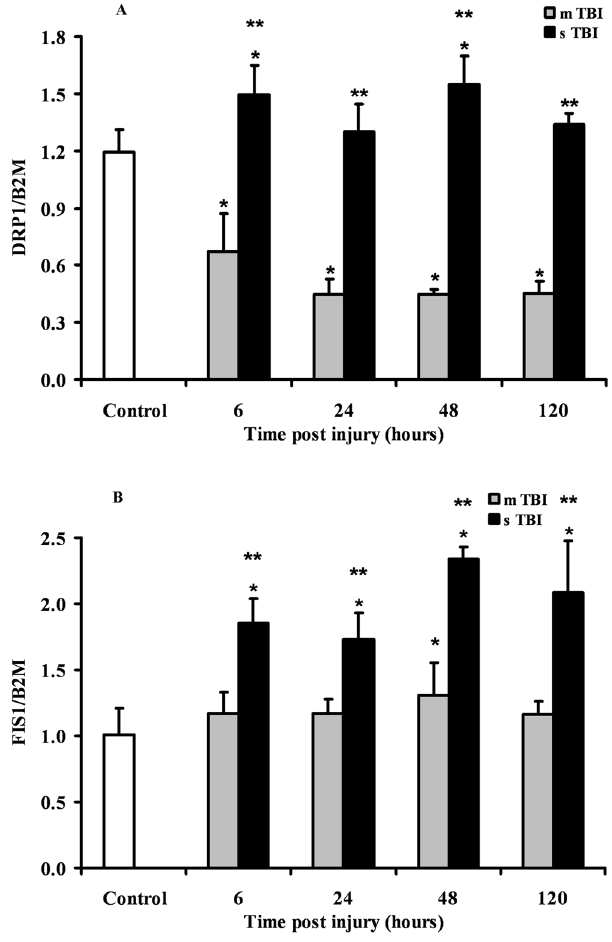
Figure 3. Changes in the expression of fission-related genes (DRP1 and FIS1) in brain tissue homogenates of rats receiving TBI of graded severity (mTBI and sTBI) at different times post-impact. Values are the mean of 6 animals. Standard deviations are represented by vertical bars. Gene expressions were calculated relatively to the housekeeping gene β -2-microglobulin (B2M). * Significantly different from controls, p < 0.05. ** Significantly different from the corresponding time of mTBI rats, p <